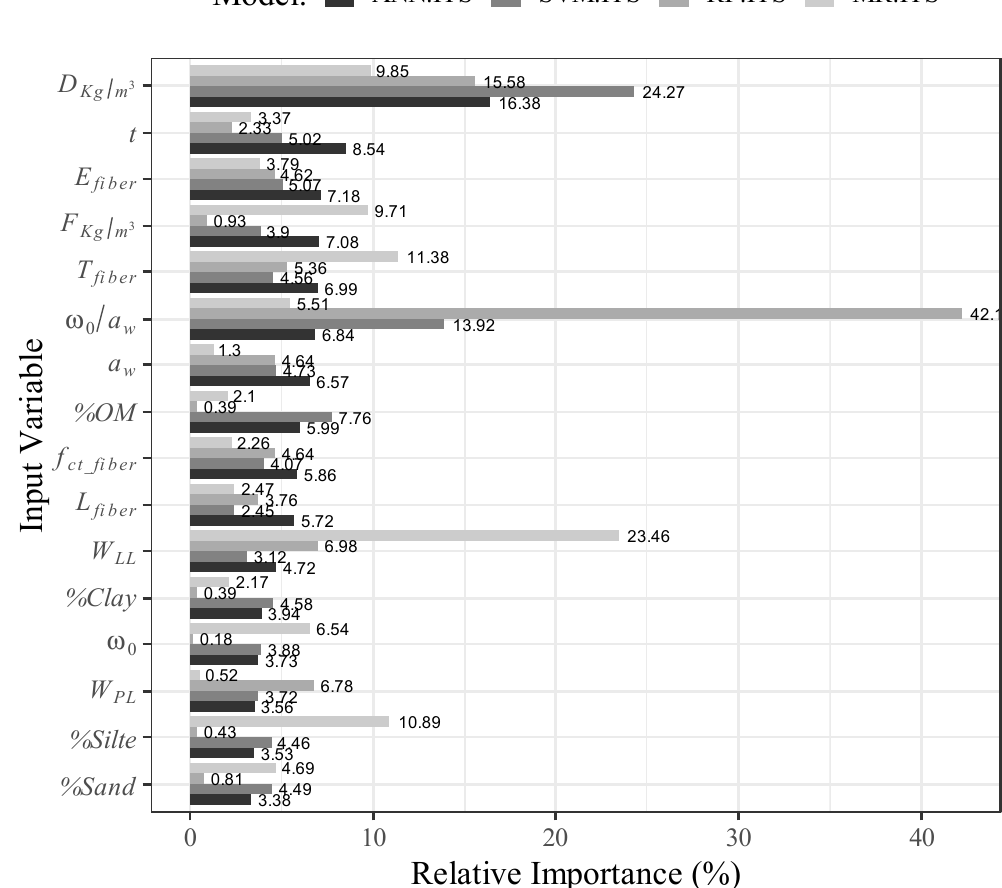
Figure 8. A comparison of the relative importance of each input variable based on a GSA in ITS prediction of soil–binder–water mixtures reinforced with fibers.